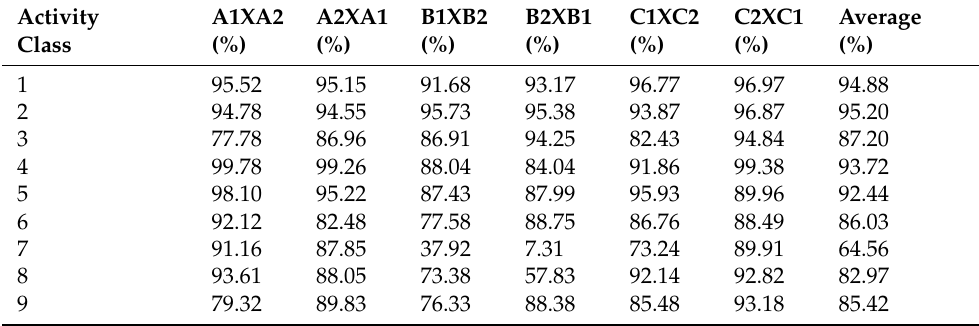
Table 7. Average scoring activity classes